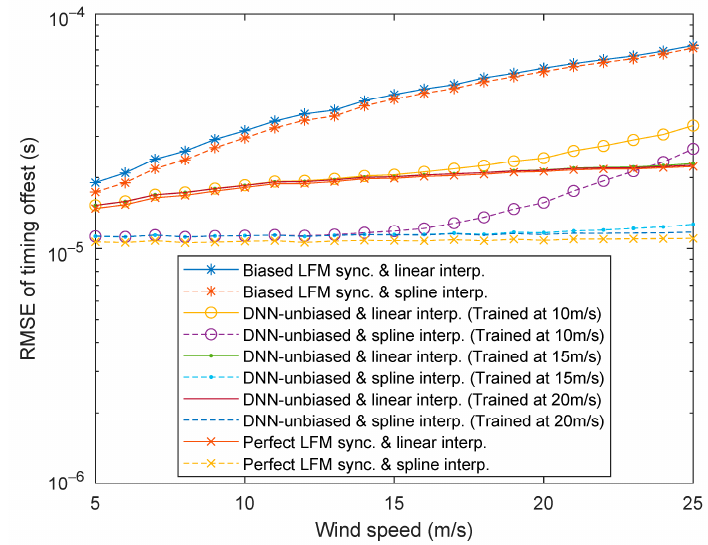
Figure 4. The timing o ff set estimation performances in the simulations. RMSE is root-mean-square error.